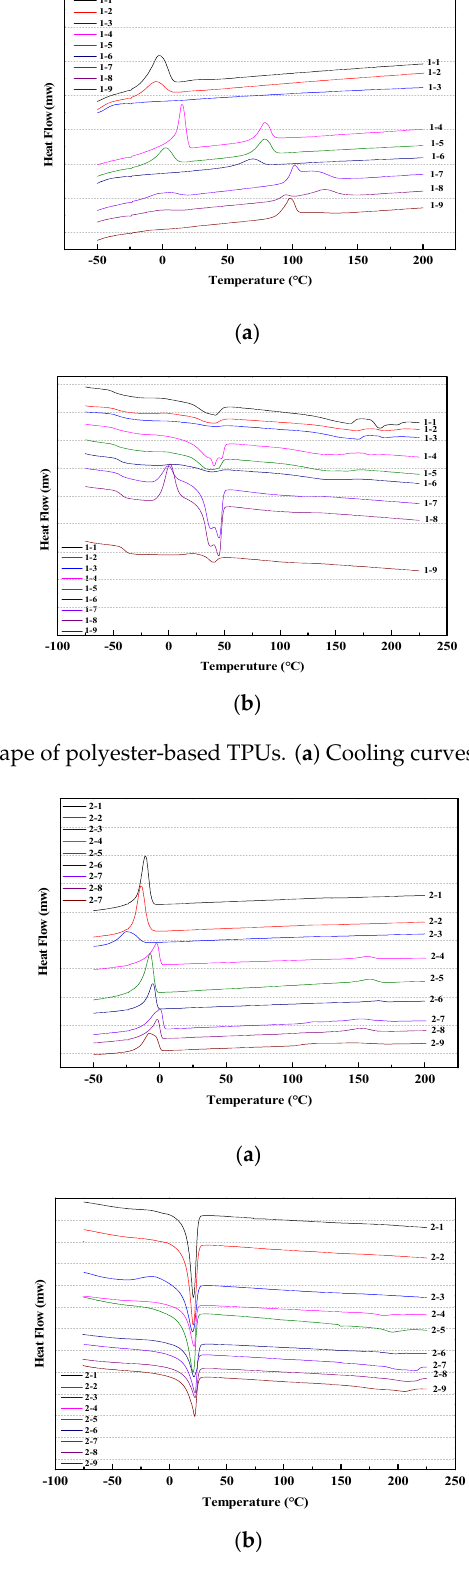
Figure 16. DSC curves shape of polyether-based TPUs. ( a ) Cooling curves; ( b ) Second heating curves.